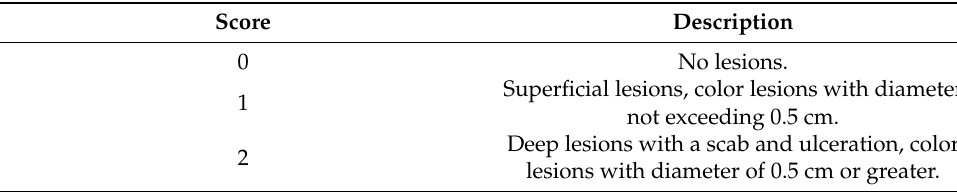
Table 2. Scale of assessment of foot pad dermatitis lesions. Score Description 0 No lesions. Superficial lesions, color lesions with diameter 1 not exceeding 0.5 cm. Deep lesions with a scab and ulceration, color 2 lesions with diameter of 0.5 cm or